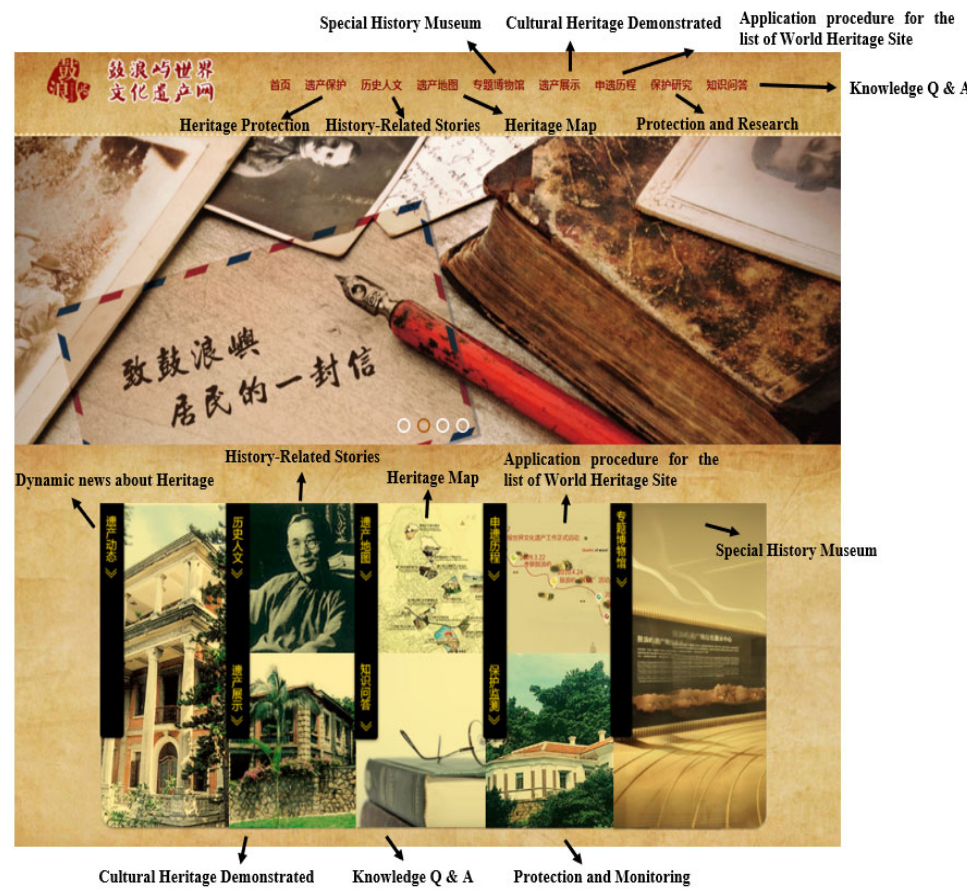
Figure 2. The official website for Gulangyu Island.